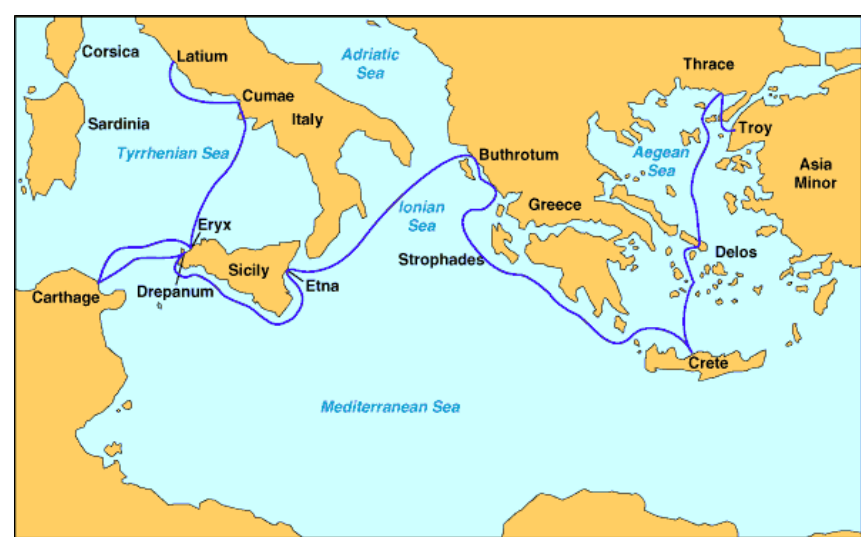
Figure 4. Map of Aeneas’s journey. Source: https://faculty.gvsu.edu/websterm/Aeneid.htm (last access: 3 March 2021).